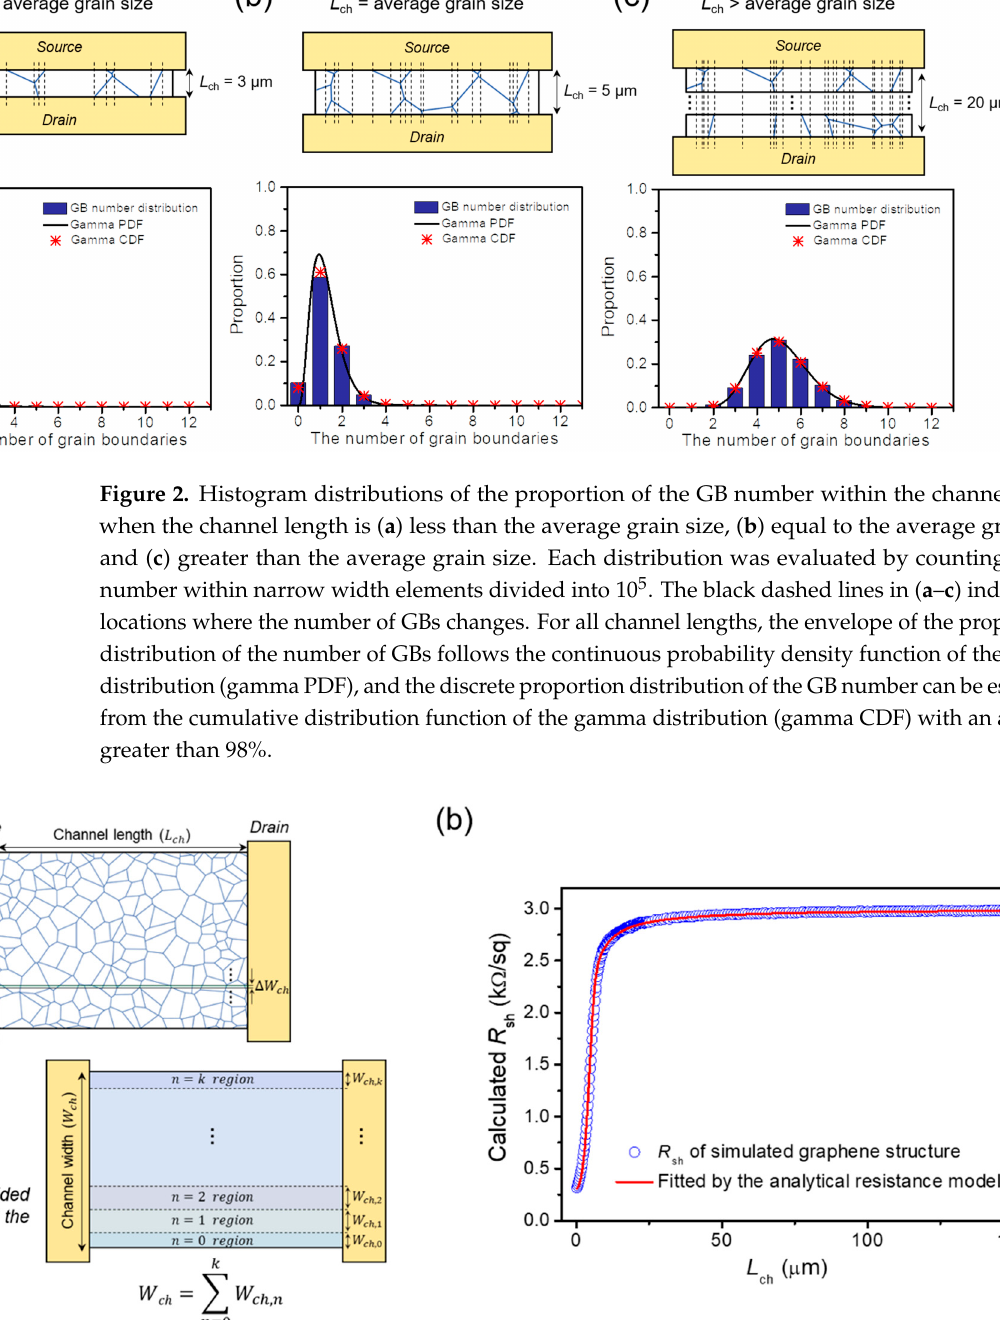
Figure 3. GB distribution-based analytical resistance model for the simultaneous extraction of the grain parameters (the average grain size, grain sheet resistance, GB resistivity) of polycrystalline graphene. ( a ) Considering the proportion distribution of the GB number estimated from the gamma CDF, the divided width elements ( Δ W ch ) can be grouped and rearranged by the number of GBs. Based on the rearranged width elements ( W ch,n ), a sheet-resistance model composed of the three- grain parameters can be induced as a function of the channel length. ( b ) The developed analytical resistance model was used to fit the calculated channel sheet resistance as a function of the channel length. The sheet-resistance dependence on the channel length can be estimated with a high fitting accuracy greater than 99.98% by adjusting three fit (i.e., grain) parameters, from which the three- grain parameters can be extracted from the analytical resistance model fitted to the R sh – L ch curve.